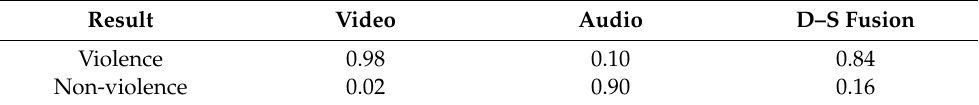
Table 3. D–S fusion result on a playing sample (probabilities).